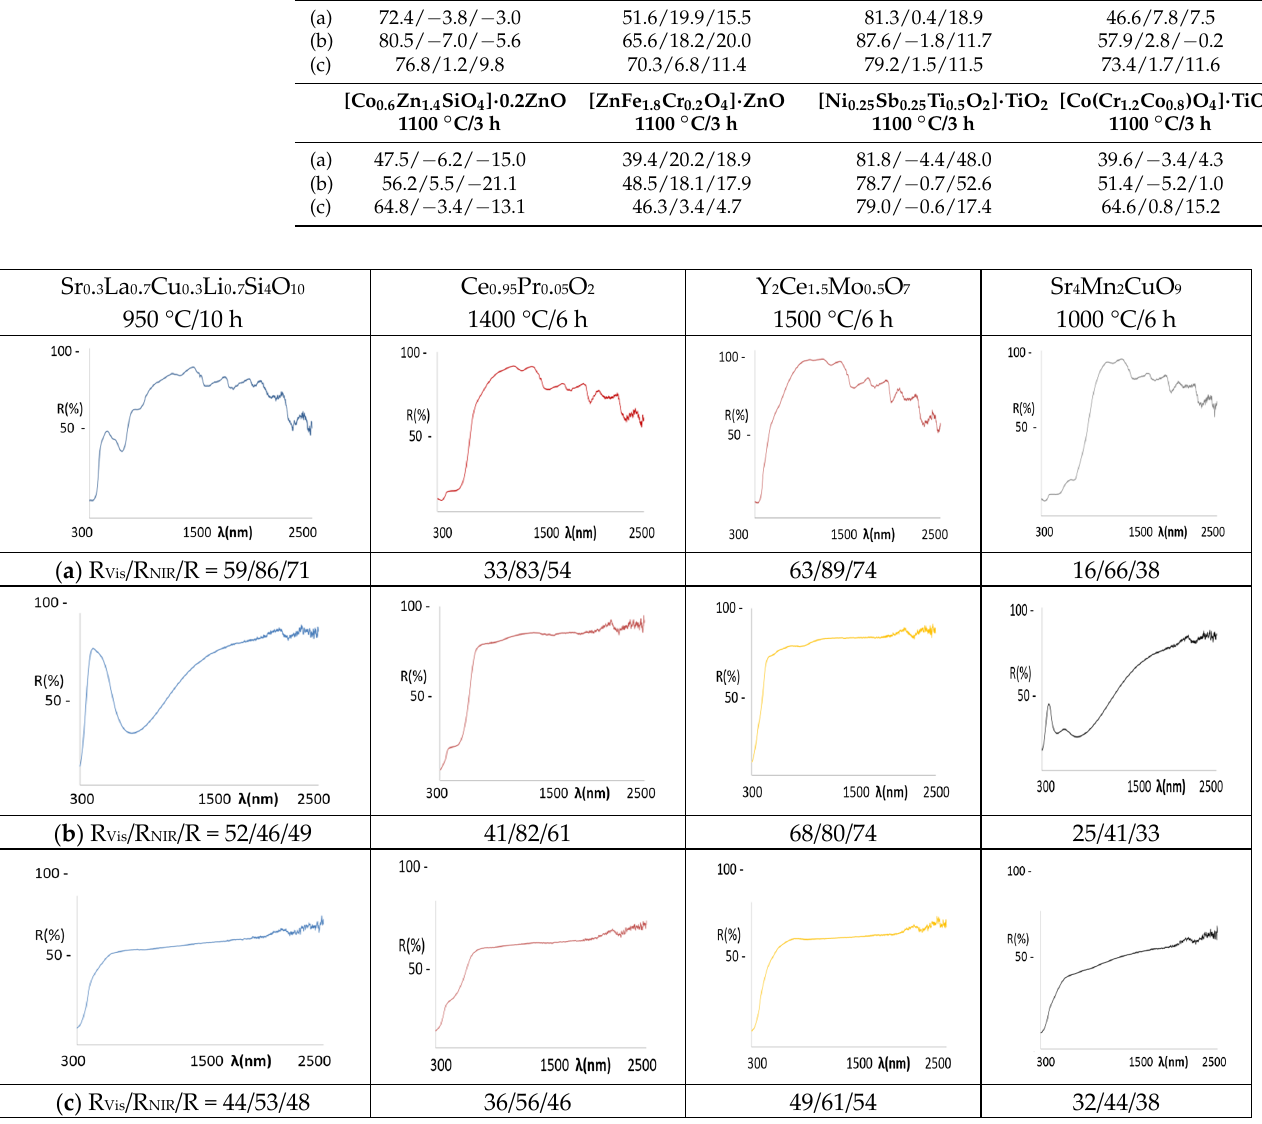
Figure 11. UV-Vis-NIR reflectance spectra of rare earth pigment applications: ( a ) 10 wt.% in colourless alkyd paint, ( b ) 3 wt.% in double firing frit (1000 °C), ( c ) 2% wt.% in porcelain powder (1190 °C).